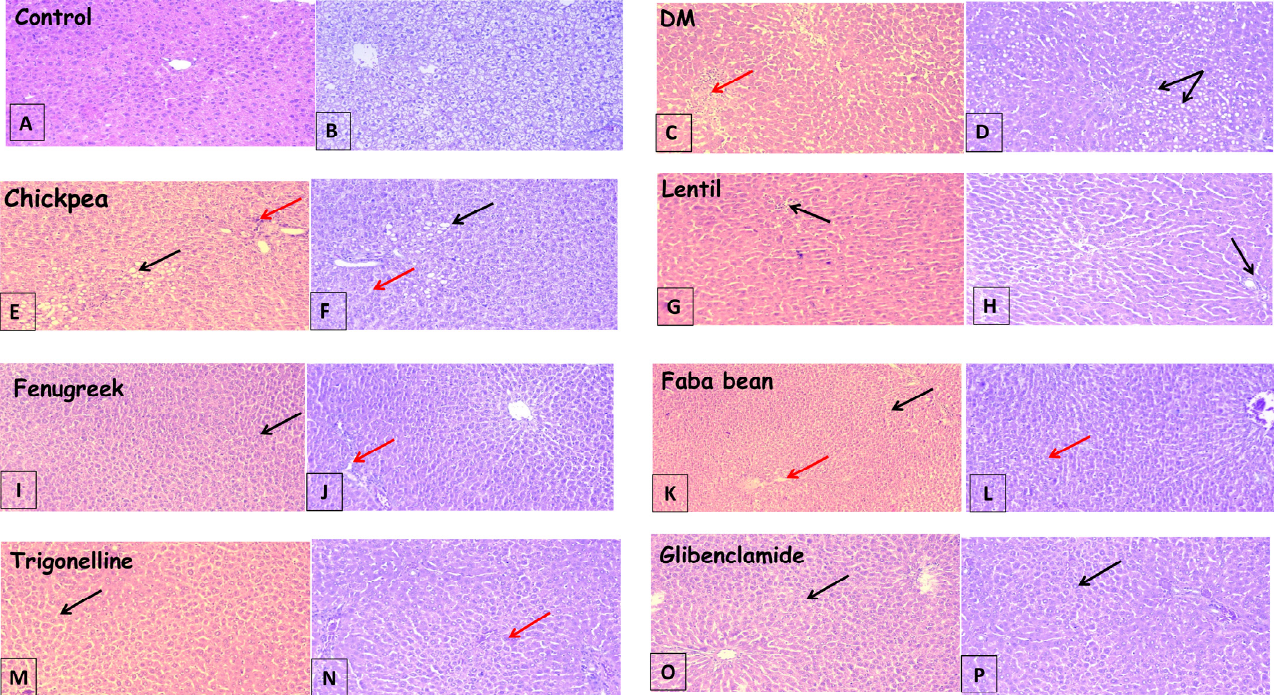
Figure 2. Photomicrographs of liver sections showing; ( A , B ): preserved lobular hepatic architecture and normal morphological appearance, ( C , D ): severe vesicular steatosis, hepatocyte ballooning (black arrow) and lobular inflammation (dashed arrow), ( E , F ): mild vesicular steatosis, hepatocyte ballooning (solid arrow) and mild inflammation (dashed arrow), ( G , H ): micro steatosis, hepatocyte ballooning (black arrow) with mild interlobular inflammation (dashed arrow), ( I–L ): intact lobular hepatic architecture, scattered few micro steatotic changes (black arrow) and minor inflammation (dashed arrow), ( M , N ): mild vacuolization of hepatocytes and mild ballooning of hepatocytes, and ( O , P ): showed more or less normal hepatic structure with minimal vacuolization. (A, C, E, G, I, K, M, and O are stained with H&E, while B, D, F, H, J, L, N, and P are Masson’s trichrome, 100×).